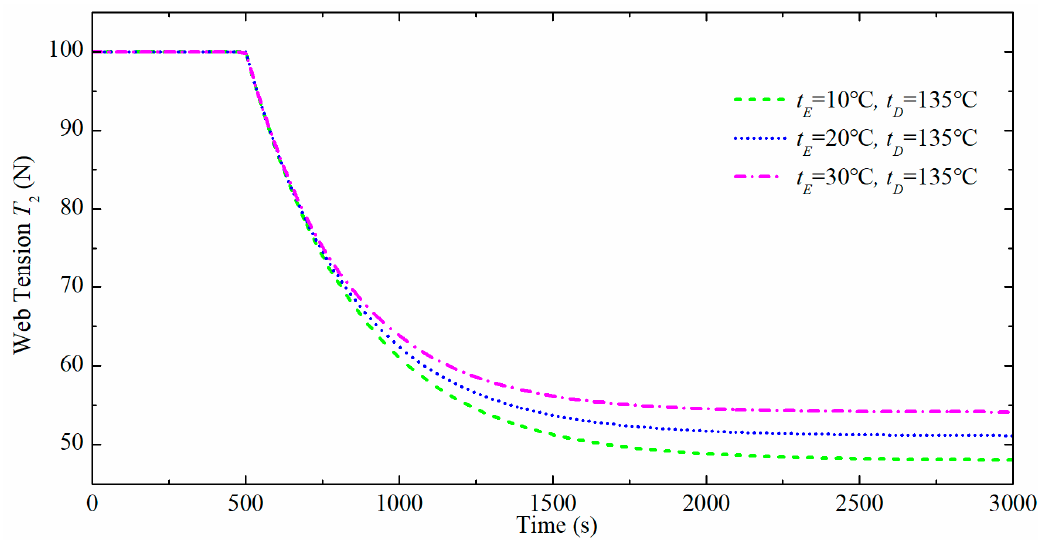
( ) T t as ( ) v t has step changes at different room temperatures 2 1